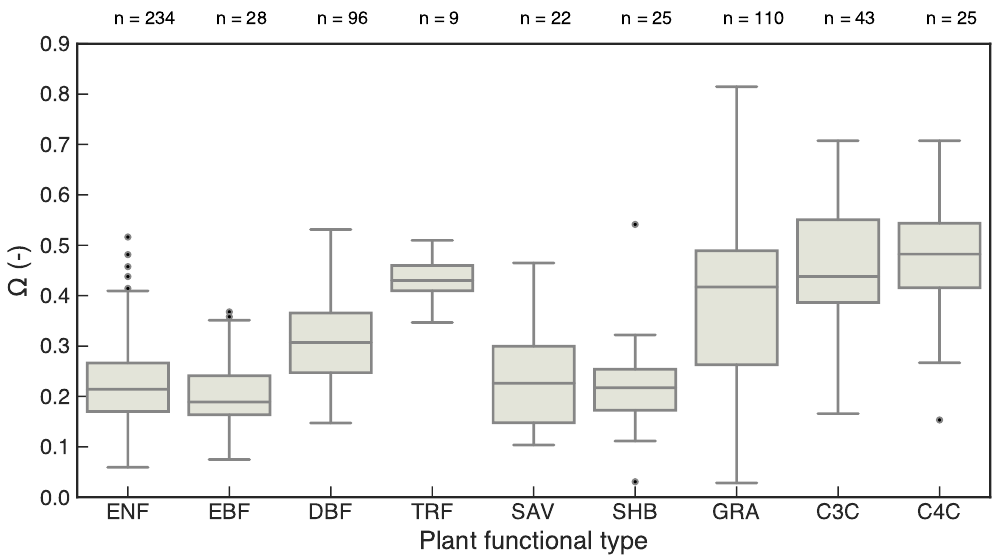
Figure 1. Box and whisker plot (line, median; box, inter-quartile range) showing the estimated coupling coefficient ( (cid:127) ) from FLUXNET data grouped by plant functional type. Whiskers extend to 1.5 times the inter-quartile range, with dots outside of the whiskers showing outliers. Plant functional types are defined as ENF – evergreen needleleaf forest, EBF – evergreen broadleaved forest, DBF – deciduous broadleaved forest, TRF – tropical rain forest, SAV – savanna, SHB – shrub, GRA – grasses, C3C – C 3 crops, and C4C – C 4 crops. Values of n indicate the number of site years for FLUXNET.